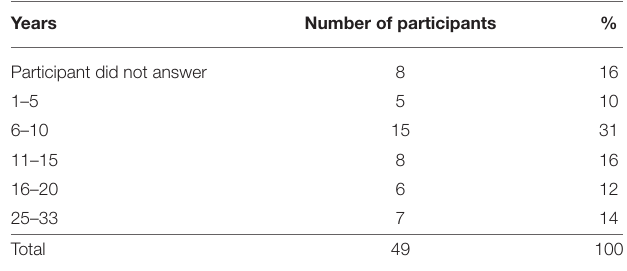
TABLE 1 | Professors’ years of teaching experience.